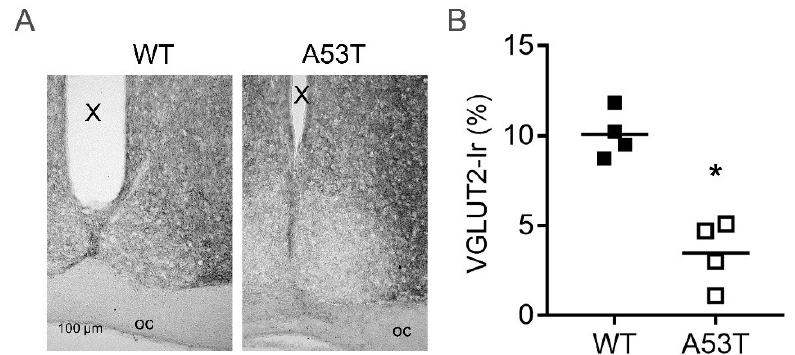
Figure 5. VGLUT2 immunoreaction (Ir) in the SCN of WT and A53T mice. ( A ) Representative photomicrographs of VGLUT2 Ir in the SCN of WT and A53T-SNCA mice; oc, optic chiasm, X, third ventricle; ( B ) The graph shows a semiquantitative analysis of VGLUT2 Ir in the SCN of WT and A53T mice. The data are shown as the area of vGLUT2 Ir in % of the SCN area; n = 4 mice for each genotype; *: p < 0.05 (Mann–Whitney test).